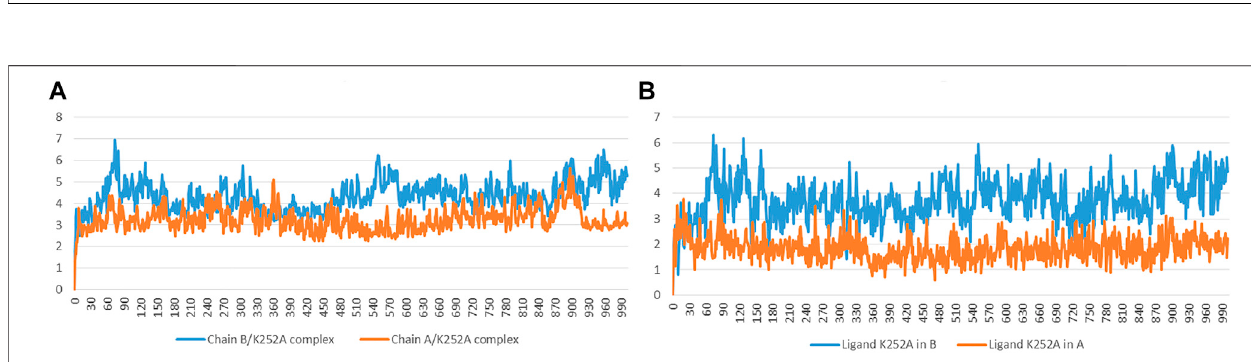
Frontiers in Pharmacology |